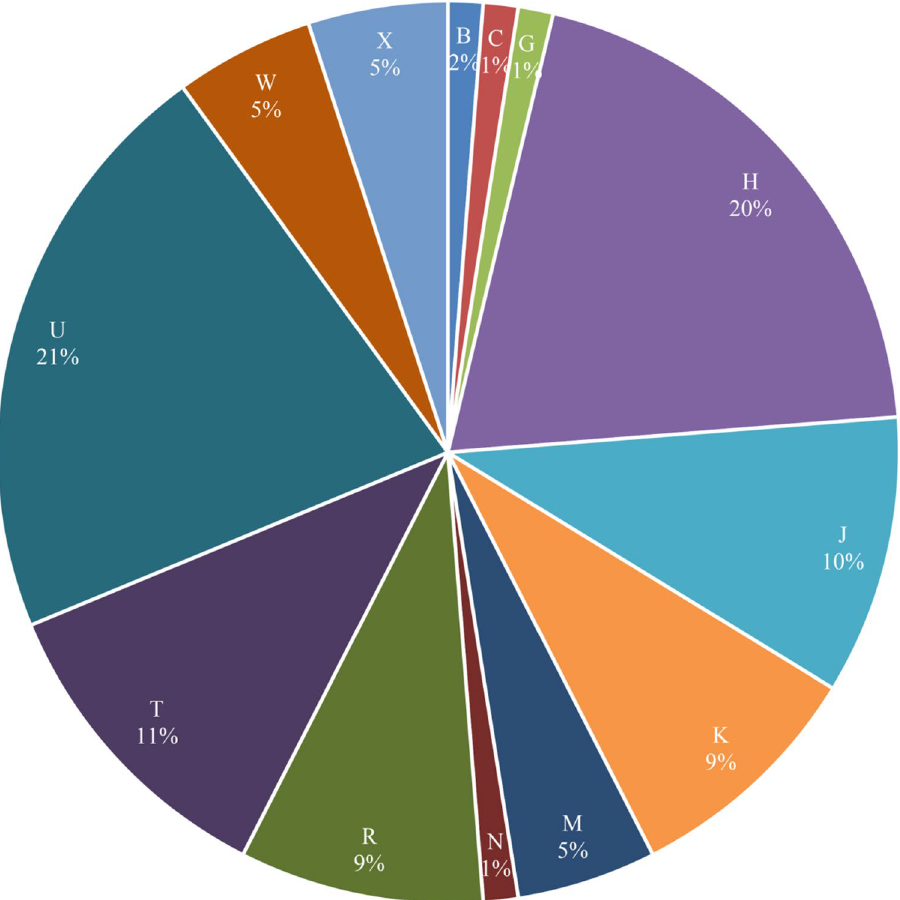
Figure 1. The haplogroup profiles of HA-Tajiks enrolled in this study. Major haplogroups were U, followed by H, T and J. Haplogroups were merged for brevity. Detailed frequencies of haplogroups in HA-Tajiks were listed in Table S2.